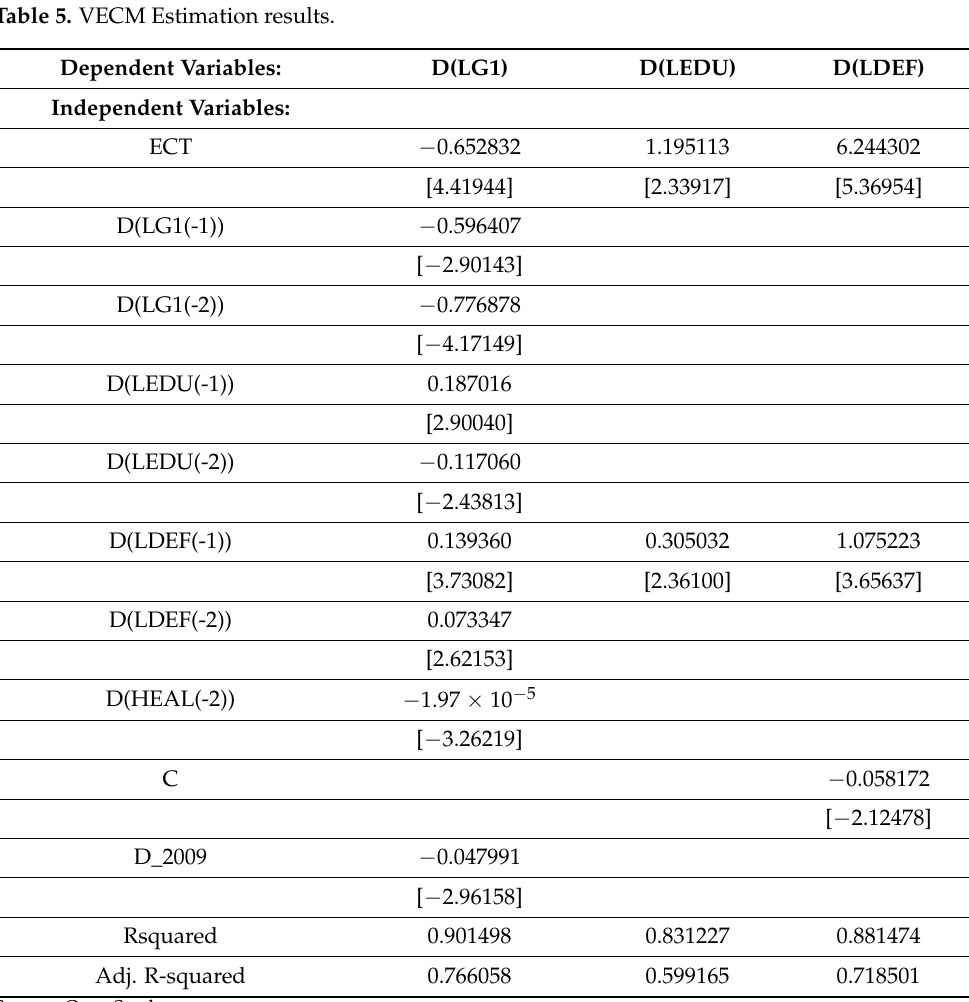
Table 5. VECM Estimation results.